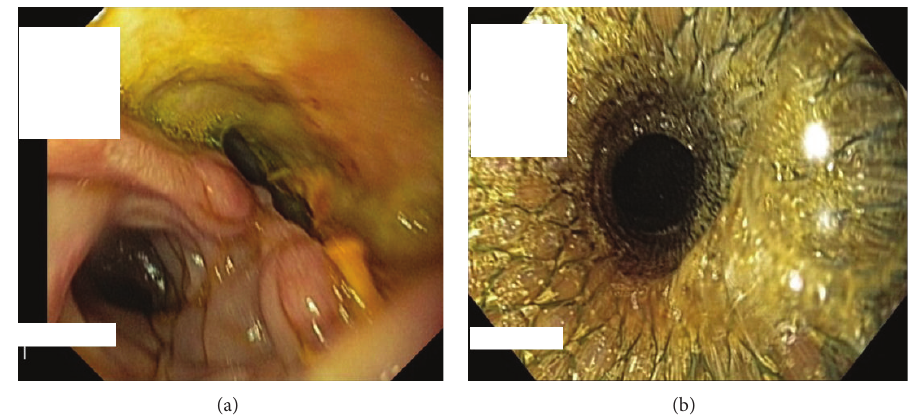
Figure 2: Esophagoscopy: esophagojejunal anastomotic fistula before (a) and after (b) stent placement.